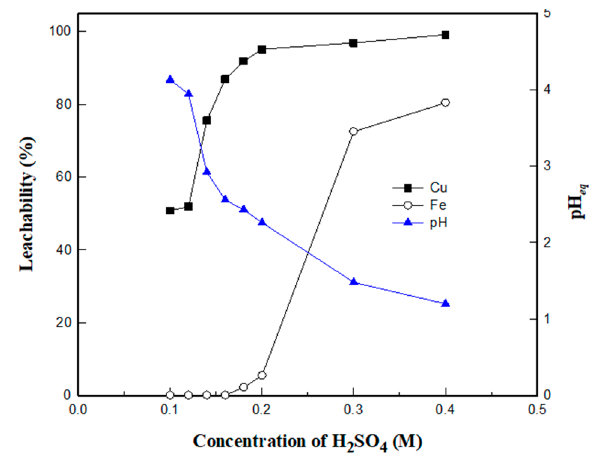
Figure 5. E ff ect of H 2 SO 4 concentration on Cu and Fe leachability. Figure 5. Effect of H 2 SO 4 concentration on Cu and Fe leachability . Figure 5. Effect of H 2 SO 4 concentration on Cu and Fe leachability .